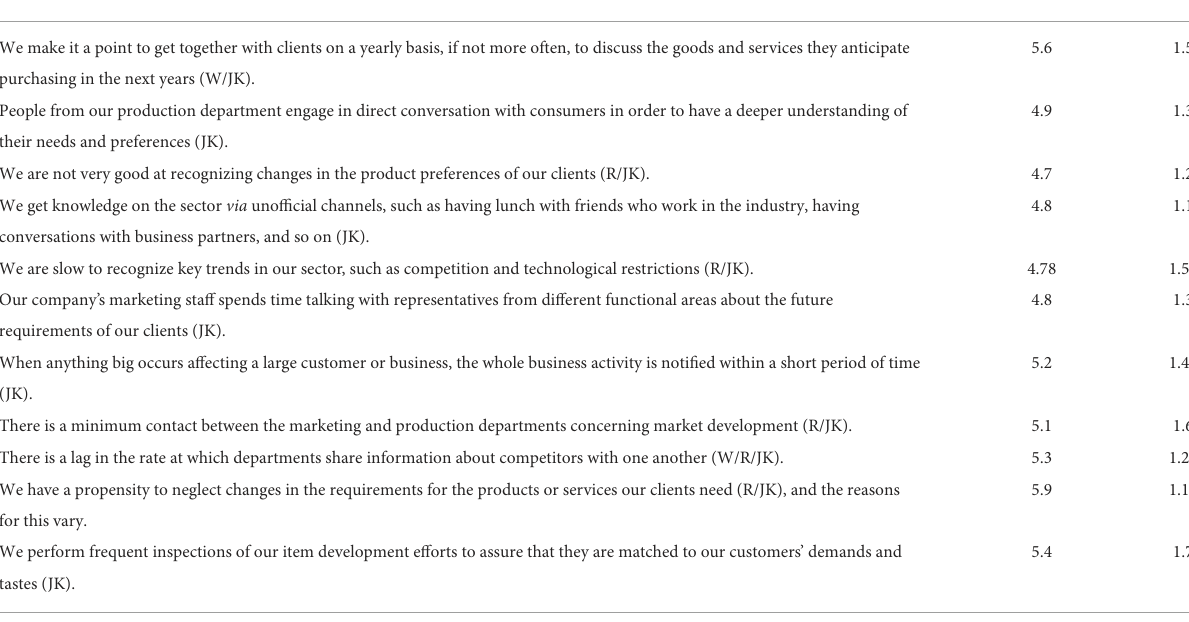
TABLE 2 Variance of the component